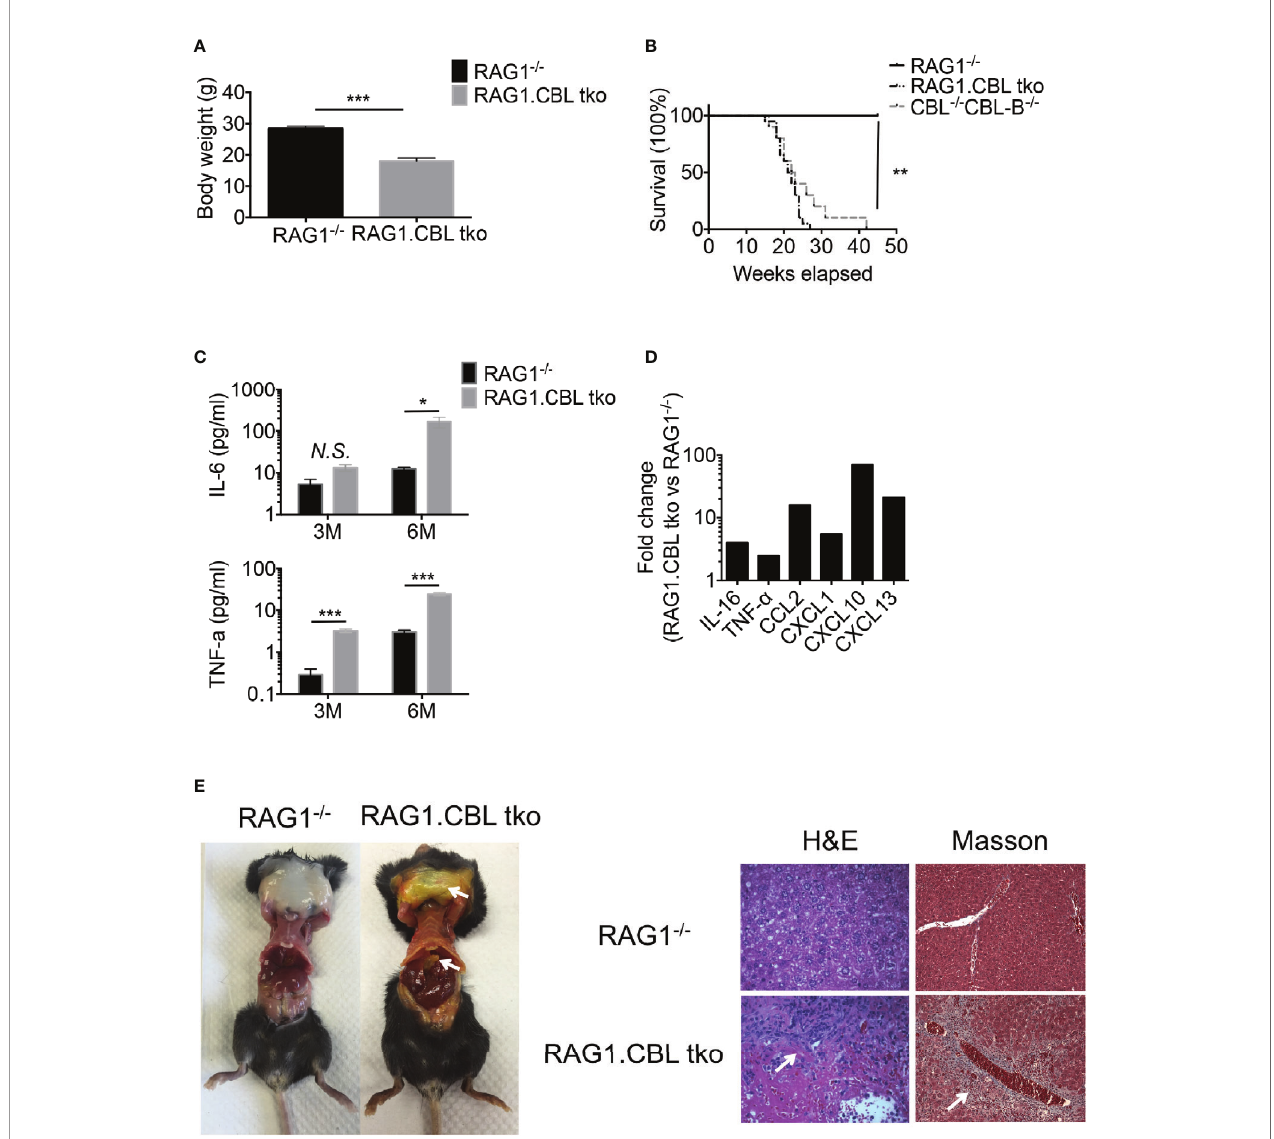
FIGURE 6 | Development of liver in fl ammation and fi brosis in CBL -/- CBL-B -/- mice is independent of lymphocytes. (A) Body weight comparison between 12-week- old RAG1 -/- and RAG1.CBL tko mice (n = 5). (B) Kaplan-Meier survival analysis of RAG1 -/- , CBL -/- CBL-B -/- , and RAG1 -/- CBL tko mice (n = 20). (C) Serum Cytokines IL-6 and TNF- a production in RAG1 -/- and RAG1.CBL tko mice by ELISA (n = 3-4). (D) Serum in fl ammatory cytokines and chemokines in RAG1.CBL tko mice. (E) Images of skin jaundice (left) and histology analysis of liver fi brosis revealed by H-E staining (right panel) and Masson staining (right panel). Data are mean ± SEM. of at least two independent experiments (C – E) . N.S., not signi fi cant; *p < 0.05; **p < 0.01; ***p <